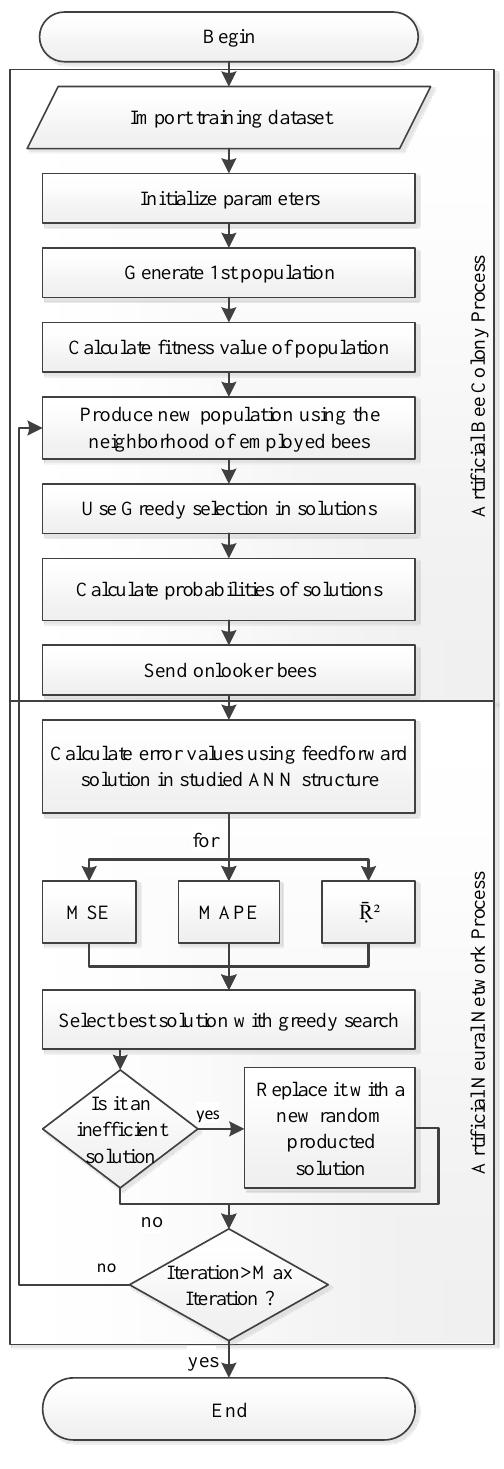
Figure 4. Flow chart of artificial neural network